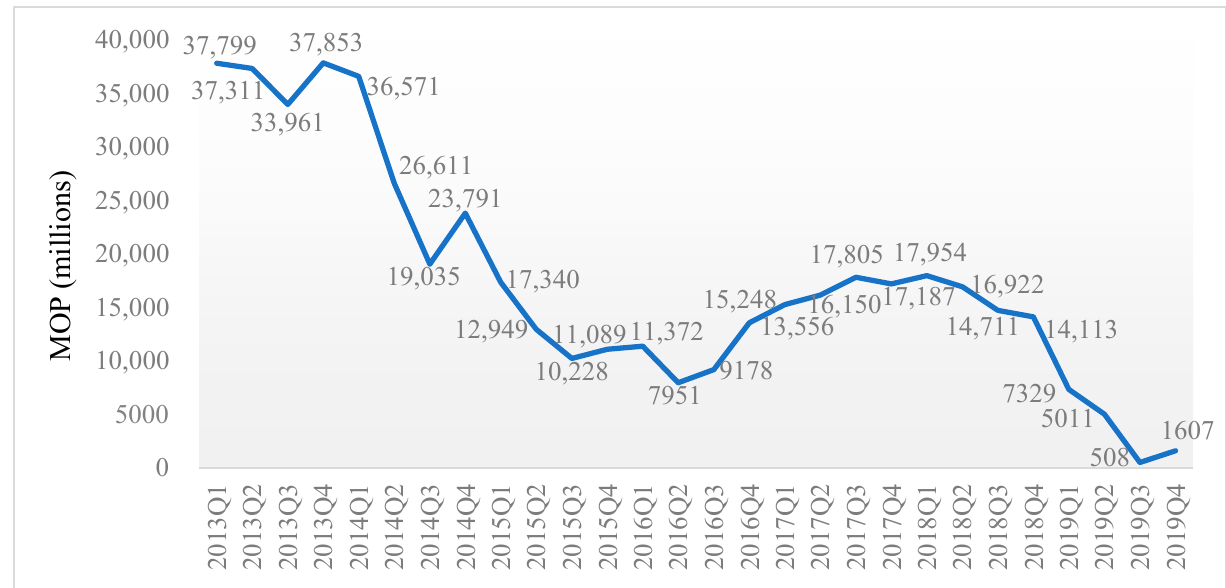
Figure 1. Revenue Difference Between VIP Baccarat and Non-VIP Baccarat.